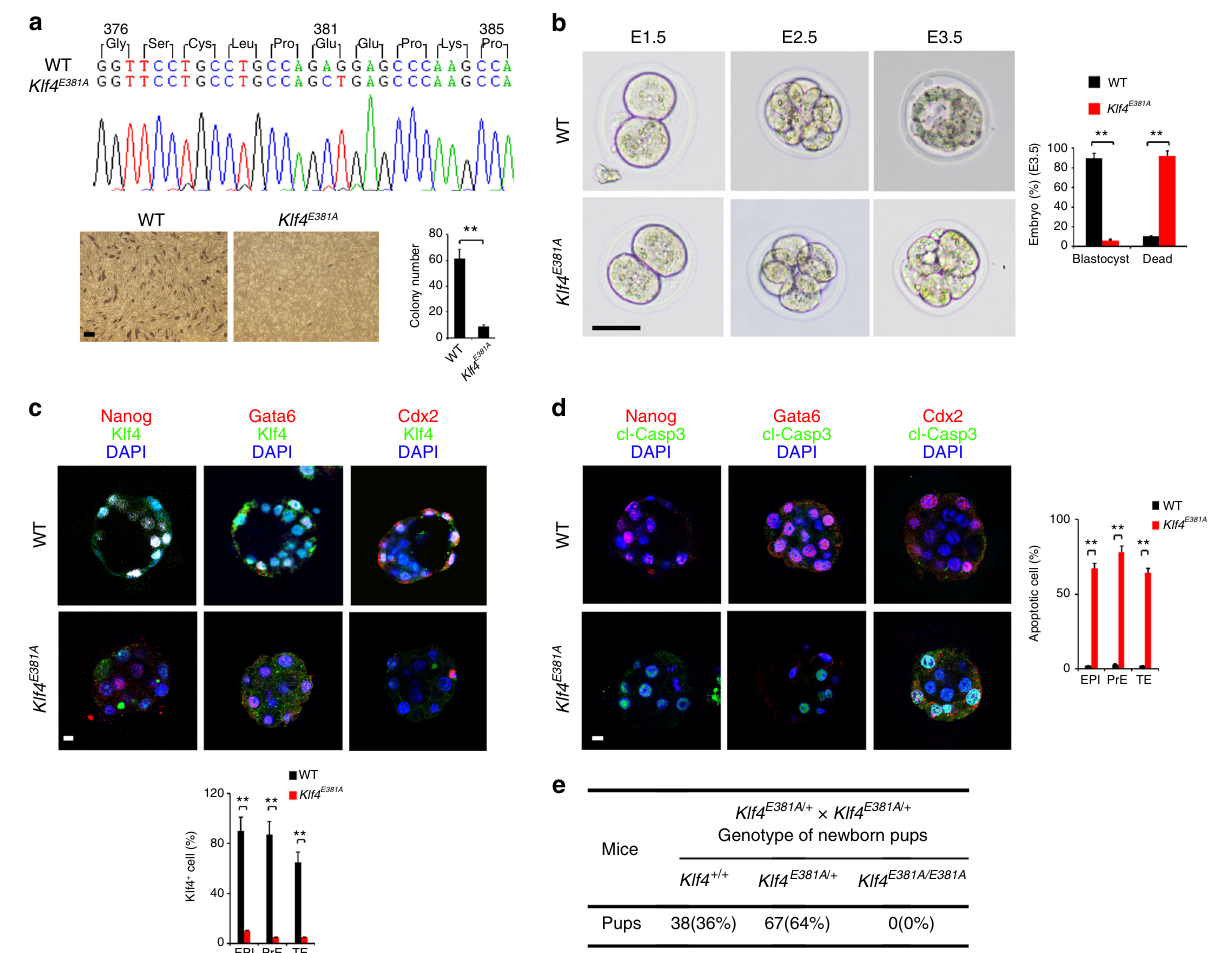
Fig. 6 A glutamylation-defective mutant of Klf4 impairs ESC pluripotency. a Klf4 E381A knockin mice were generated by a CRISPR/Cas9 approach. MEFs were isolated and induced for iPS formation as in Fig. 5a. Scale bar, 100 μ m. AP-positive colony numbers per 10 4 cells were calculated and shown as means ± S.D. ** P < 0.01, n = 4. b Fertilized eggs at E3.5 embryonic stage were isolated from pregnant mice after heterozygotes crossing. Embryo genotype was con fi rmed by both GT335 immunostaining and PCR of genomic DNA. Scale bar, 100 μ m. Distribution of embryonic stage at E3.5 was counted as means ± S.D, ** P < 0.01. For WT embryos, n = 101. For Klf4 E381A embryos, n = 87. c Indicated preimplantation embryos from WT and Klf4 E381A knockin mice were stained with cell fate markers (Nanog for epiblast (EPI), Gata6 for primitive endoderm (PrE), and Cdx2 for trophectoderm (TE)) together with Klf4. n = 34 for WT embryos and n = 28 for Klf4 E381A embryos (anti-Nanog staining), n = 41 for WT embryos and n = 25 for Klf4 E381A embryos (anti-Gata6 staining), and n = 31 for WT embryos and n = 29 for Klf4 E381A embryos (anti-Cdx2 staining). d Indicated preimplantation embryos were stained with cell fate markers as well as cleaved caspase 3 (cl-Casp3). The percentage of positive cell in each germ layer was counted as means ± S.D, ** P < 0.01. Scale bar, 20 μ m. n = 40 for WT embryos and n = 31 for Klf4 E381A embryos (anti-Nanog staining), n = 37 for WT embryos and n = 30 for Klf4 E381A embryos (anti-Gata6 staining), and n = 37 for WT embryos and n = 25 for Klf4 E381A embryos (anti-Cdx2 staining). e Klf4 E381A pups were genotyped after heterozygotes crossing. Student ’